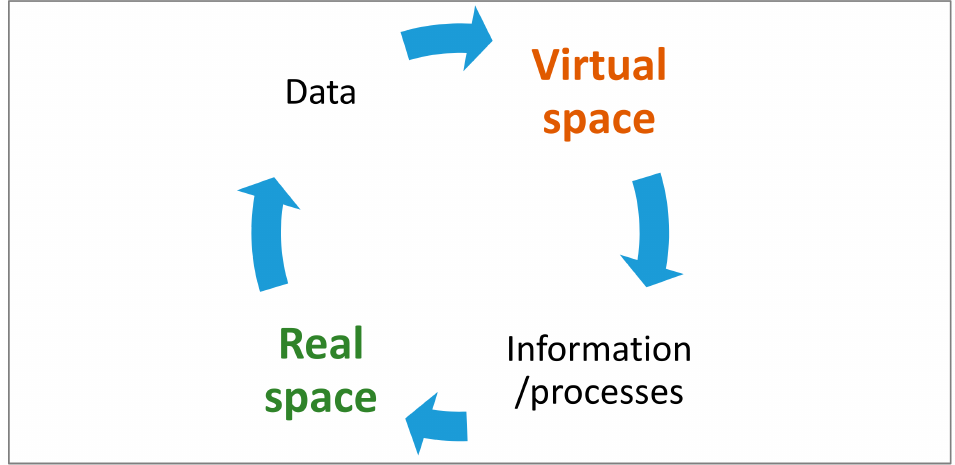
Figure 3. Key components of digital